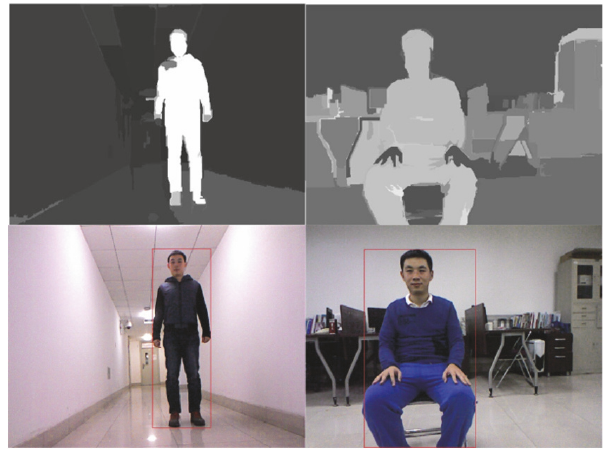
Figure 8: General performance experiment.